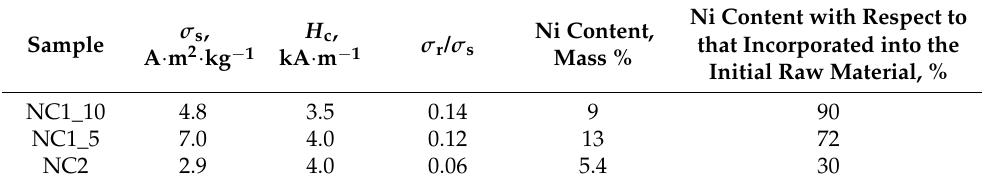
Table 6. Magnetic properties of synthesized